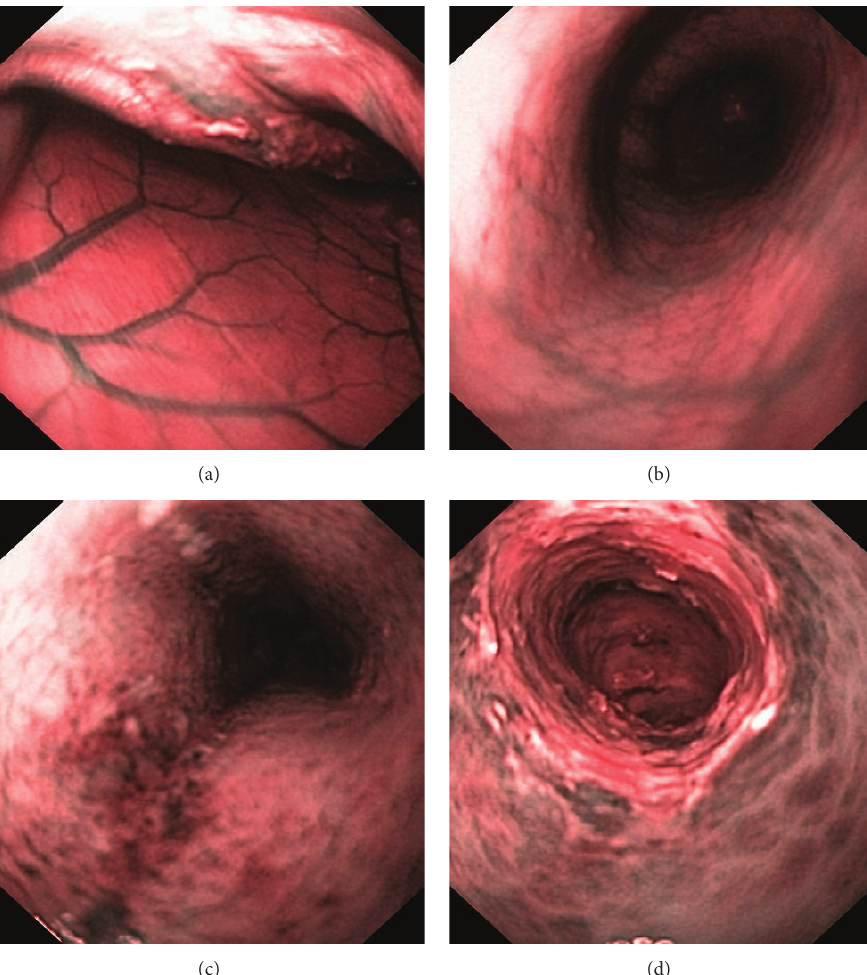
Figure 3: Endoscopic appearances of control rats ((a) and (b)), a rat treated with DTCM-G (c), and a rat treated with DHMEQ (d). Narrow- band imaging (NBI) was used, which provides twice the viewable distance and offers a much greater contrast between the blood vessels and the mucosa.